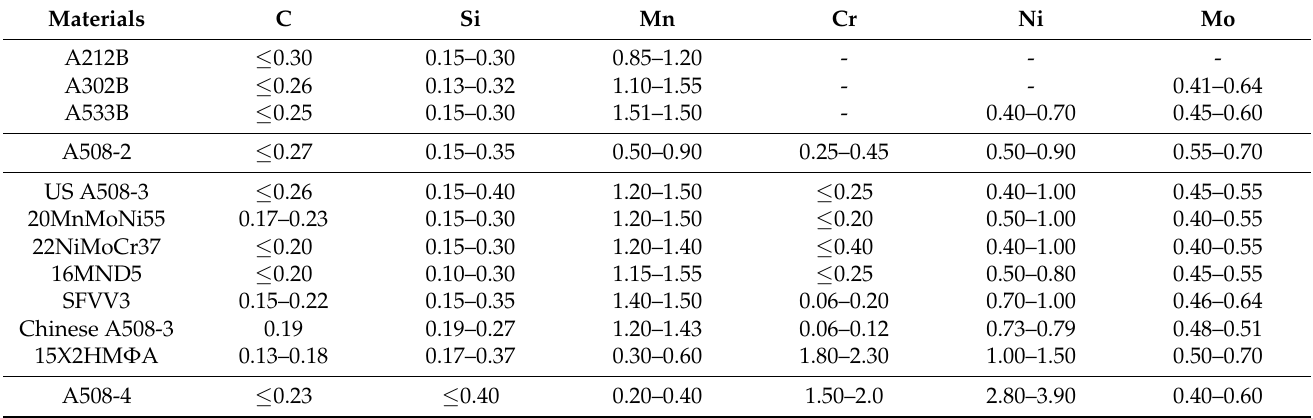
Table 1. The content of main alloying elements of reactor pressure vessel steel for PWR (wt.%) [24,26].